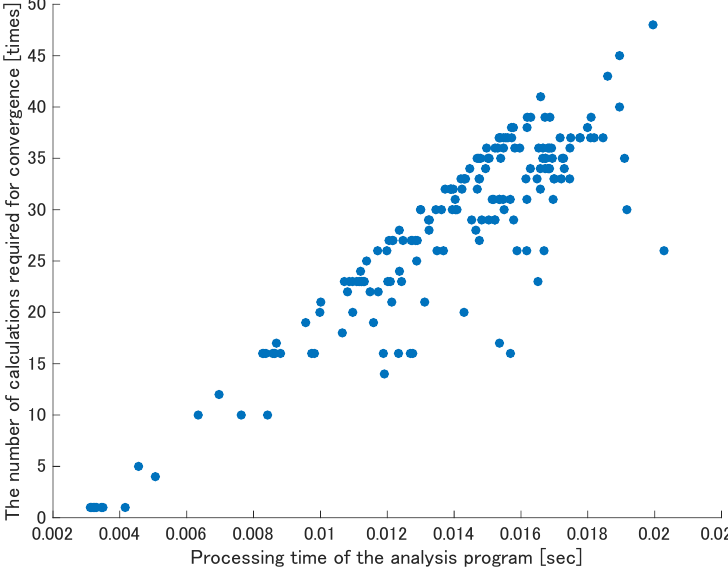
Figure 16. The relation between the processing time and the number of iterative calculations in Over-constraint